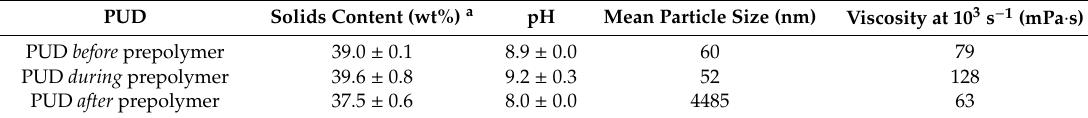
Figure 5. Appearance of the PUDs. Table 2. Solids content, pH, mean particle size and viscosity values taken at a shear rate of 10 3 s − 1 measured at 25 °C of the PUDs.